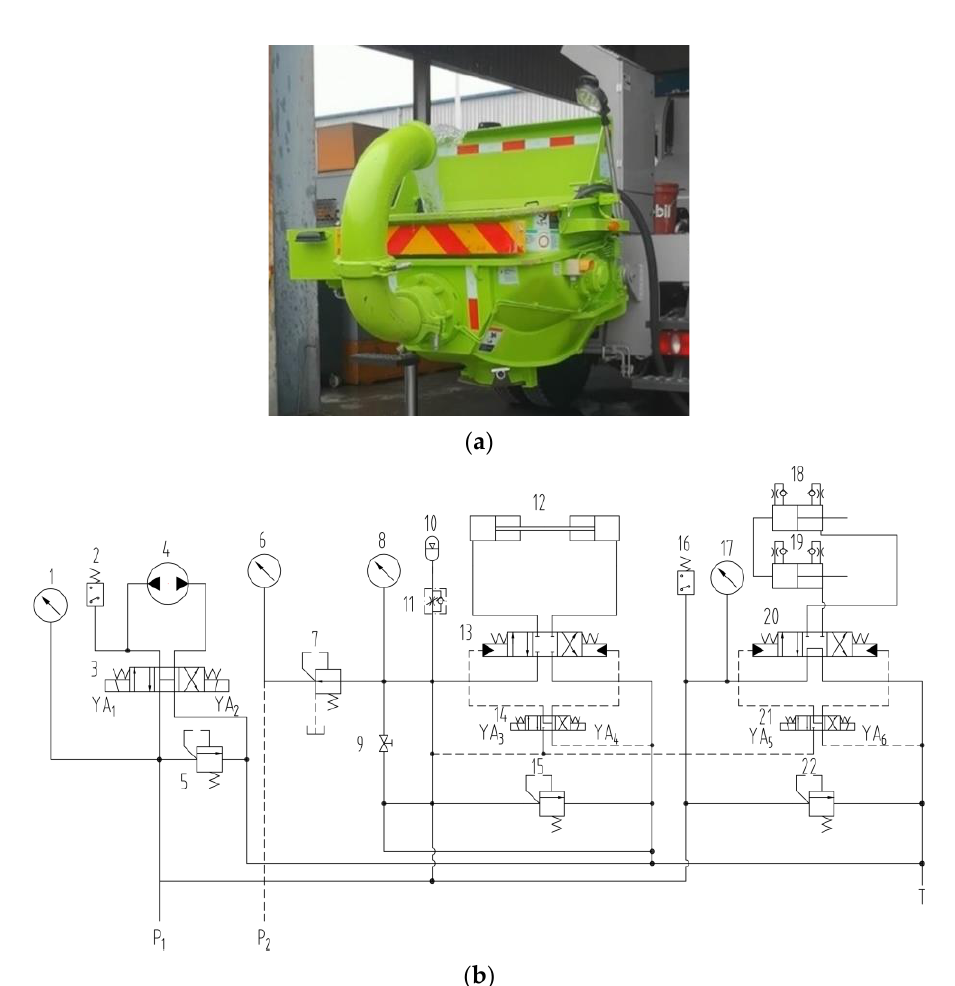
Figure 8. ( a ) Concrete pumping truck; ( b ) Schematics of concrete pumping system. Figure 9 illustrates the pumping effectiveness load in this mechanism.